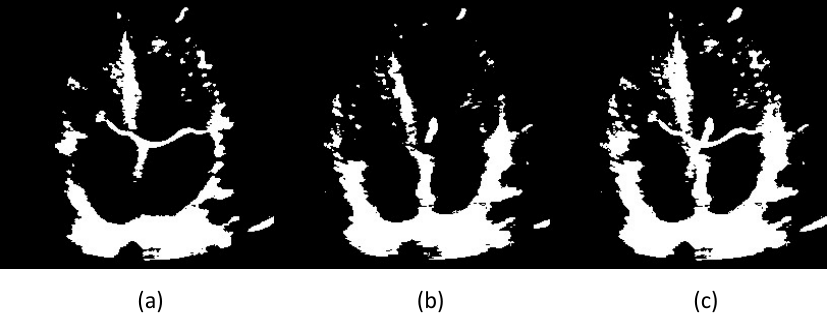
Figure 1. Two frames of a heart’s ultrasound video after binarizing, ( a , b ) are the two frames whose centroids are farthest from each other, ( c ) is obtained by combining the two, i.e., B x + B y